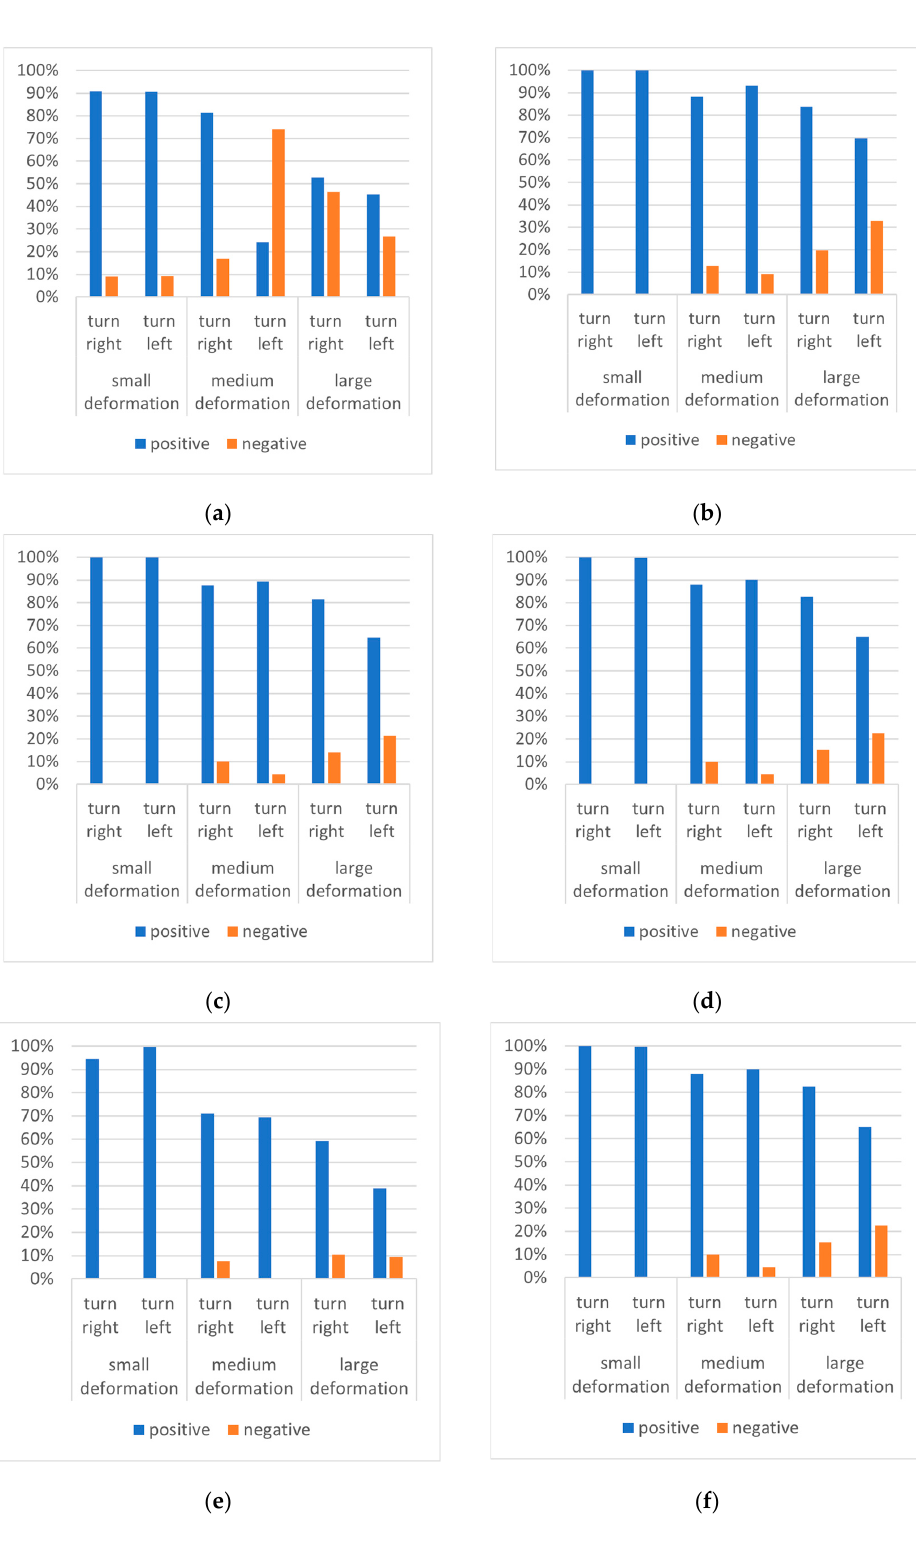
Figure 16. The share of positively and negatively matched markers for the entire pattern, for three example pairs of images, depending on the direction of rotation of the marker pattern: ( a ) Large search range (50 px) with marker removal; ( b ) large search range (50 px) without removing markers; ( c ) medium search range (10 px) with marker removal; ( d ) medium search range (10 px) without removing markers; ( e ) small (5 px) search range with marker removal; ( f ) small search range (5 px) without removing